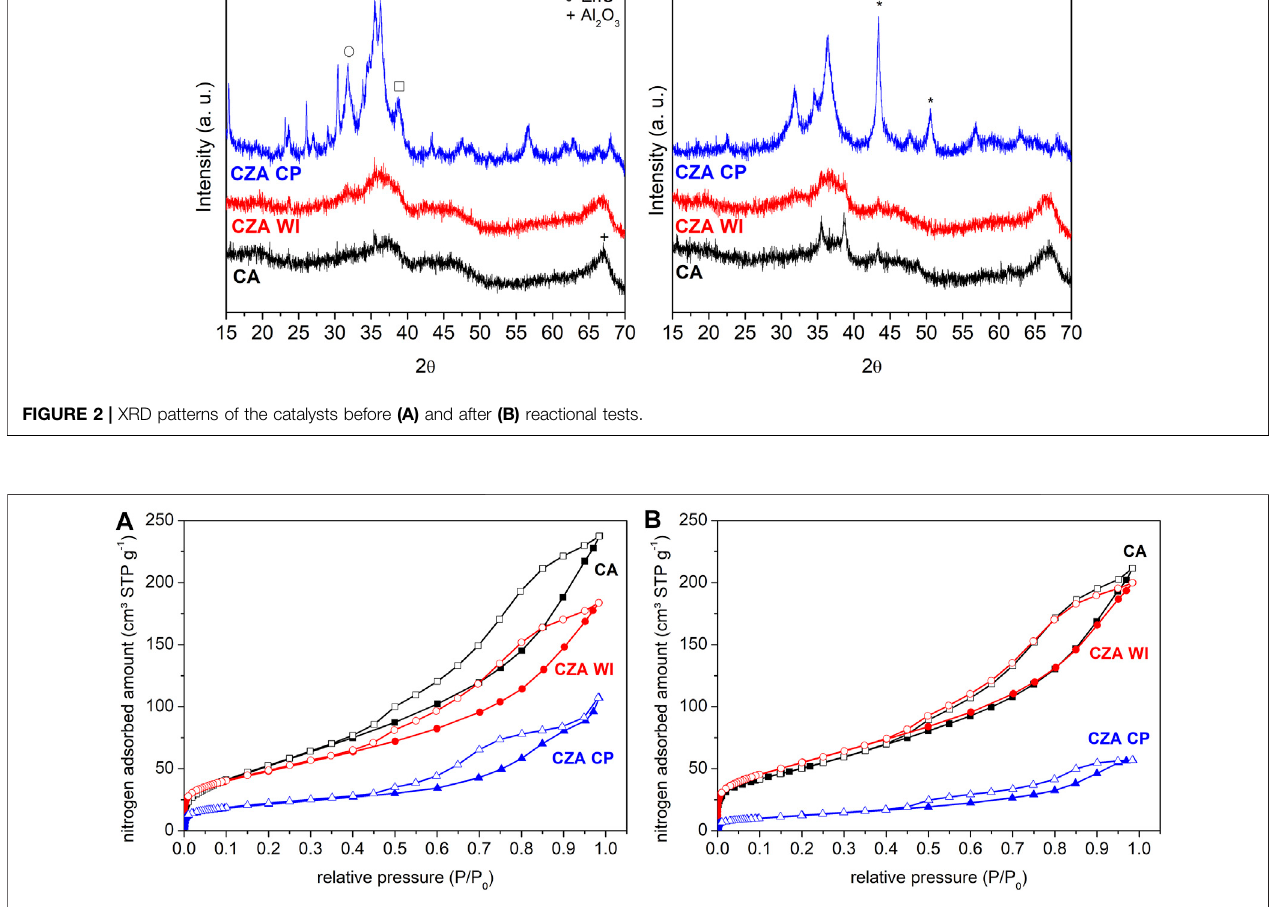
FIGURE 3 | N 2 adsorption isotherms at − 196 ° C for catalysts (A) before and (B) after reaction.